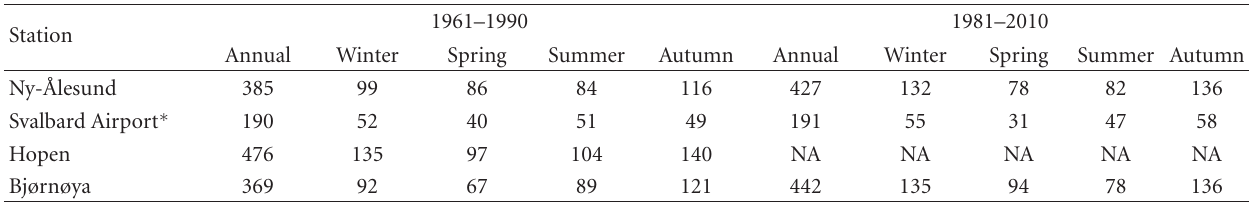
Table 3: Average precipitation totals (in millimetres) during 1961–90 and